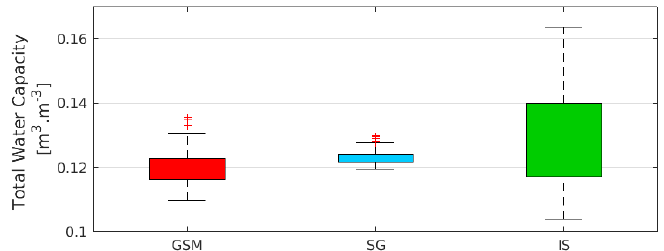
Figure 9. TWC of the fields simulated in this study derived from GSM and SG and of 45 fields within the study area estimated with in situ (IS)